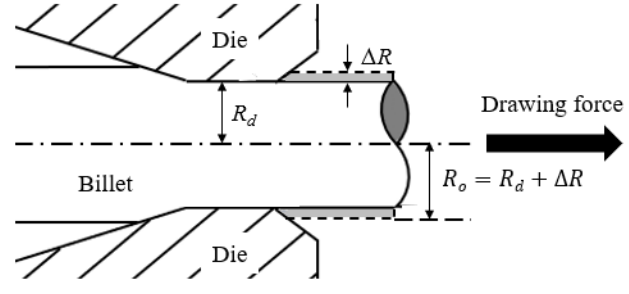
Figure 1. Schematic diagram of drawing processes.